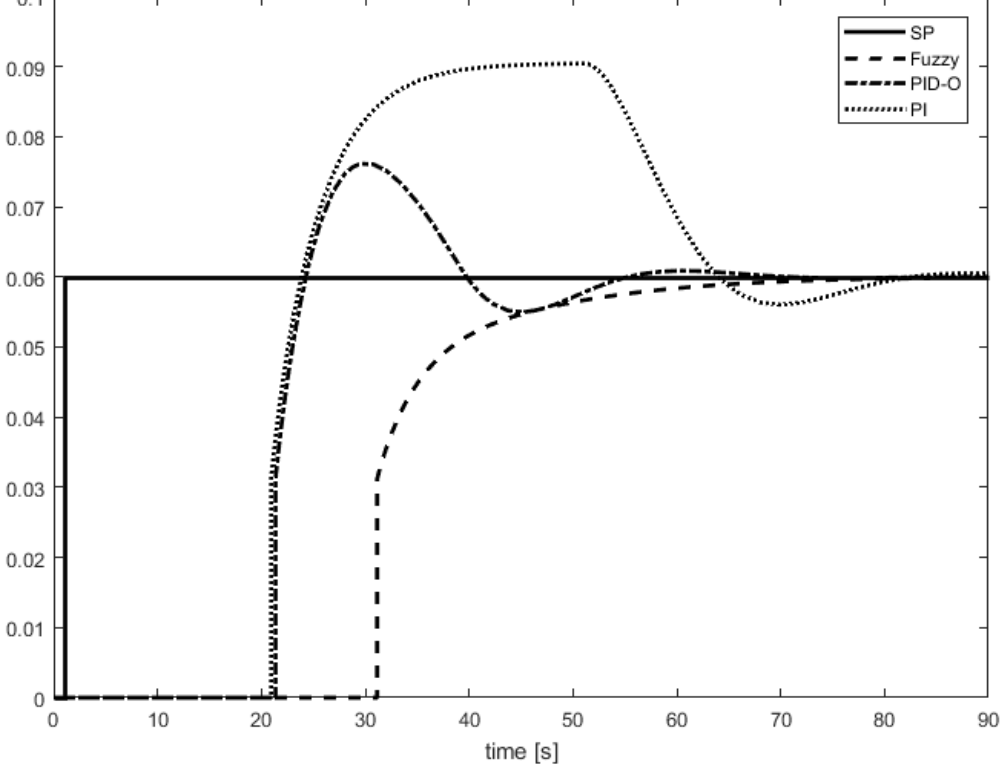
Figure 14. Comparison of control methods— n .